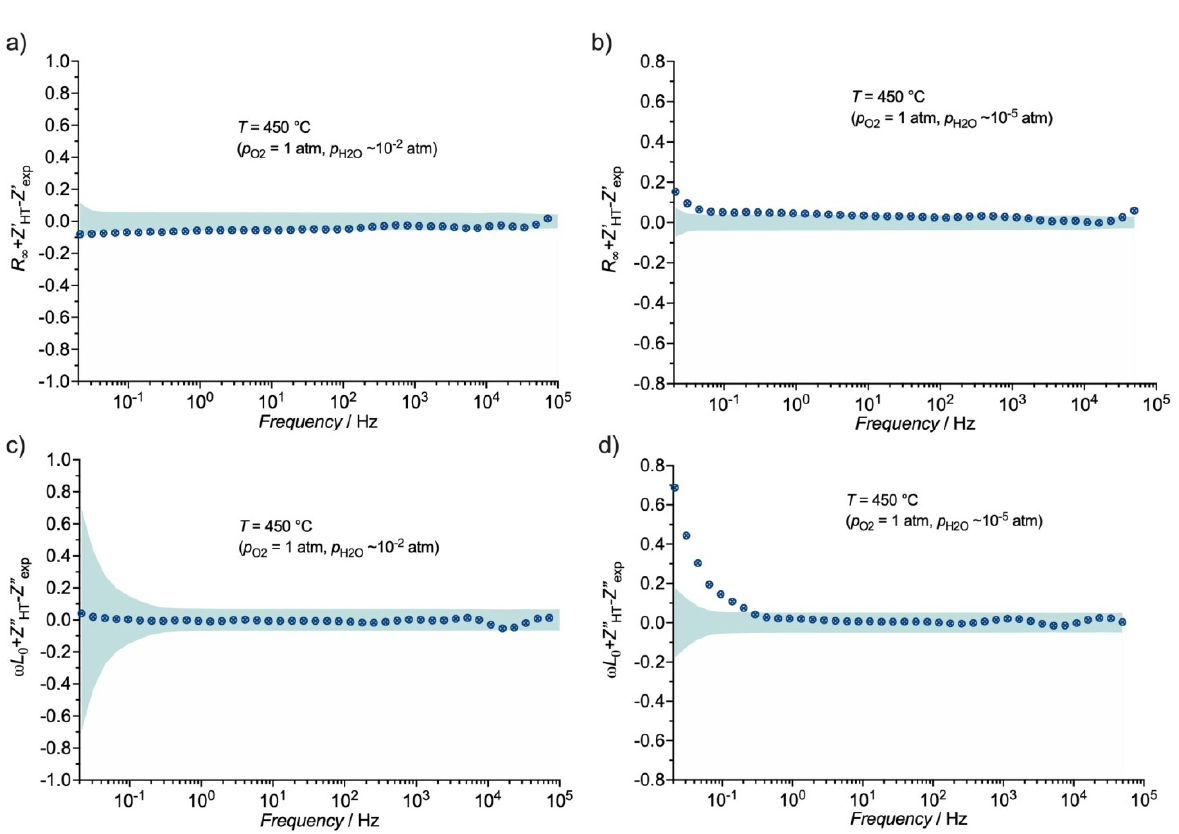
Figure 5. Residuals of the Bayesian Hilbert transform (BHT) data: Wet conditions ( a ) real and ( b ) imaginary; low humidity conditions ( c ) real and ( d ) imaginary.